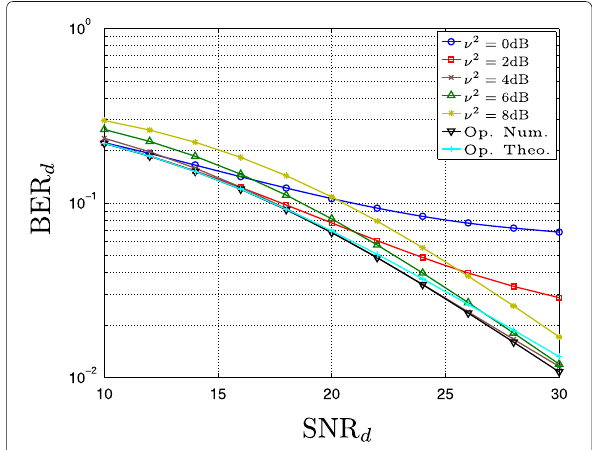
Fig. 6 Theoretical and numerical optimal BER as a function of the SNR d . Fixed BER curves for ν 2 = 0, 2, 4, 6 and 8dB are included for comparison